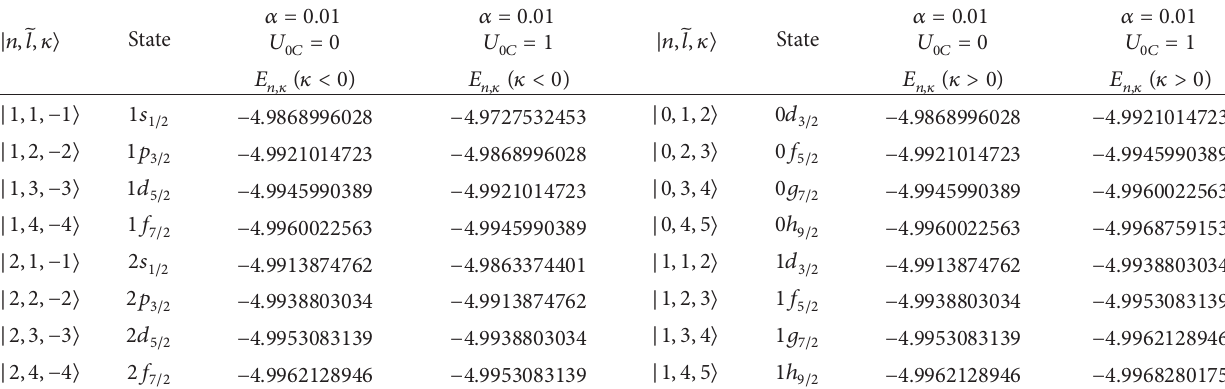
Table 6: The bound state energy eigenvalues in unit of fm −1 of the p-spin symmetry Coulomb potential. Here the first states column according to (𝑙,𝑗) and second states column (𝑙 + 2,𝑗 + 1)